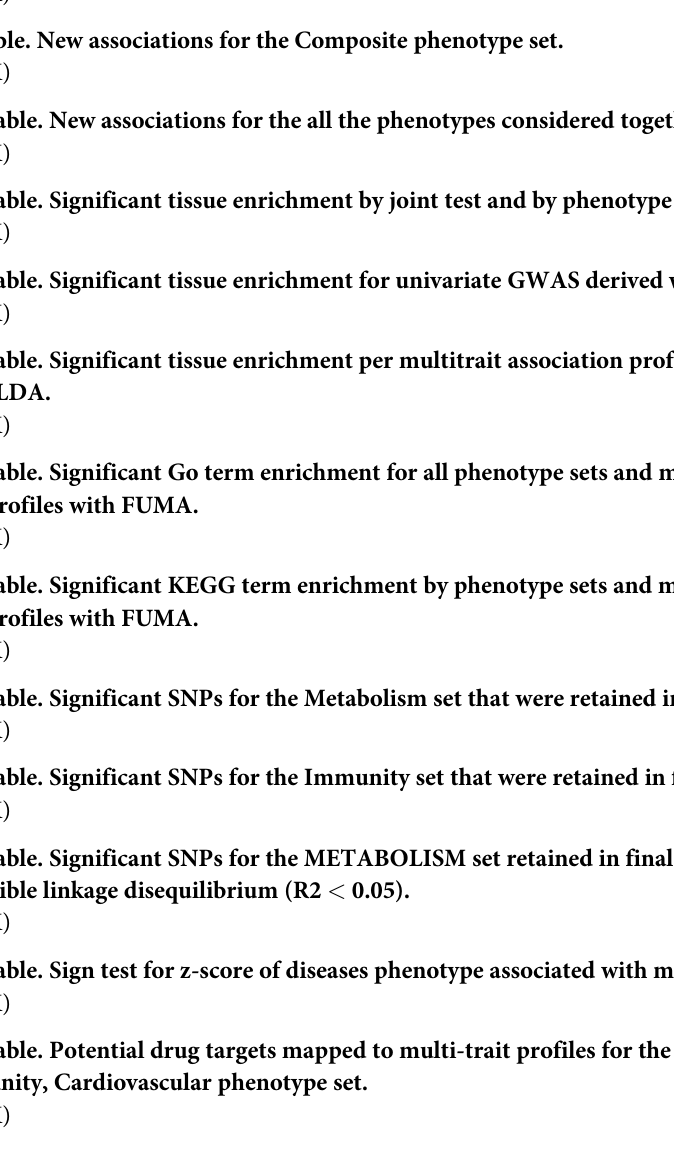
S3 Table. Genetic correlation. S4 Table. New associations for the Metabolism phenotype set. S5 Table. New associations for the Cardiovascular phenotype set. S6 Table. New associations for the Immunity phenotype set. S7 Table. New associations for the Anthropometry phenotype set. S8 Table. New associations for the Psychiatric phenotype set. S9 Table. New associations for the Composite phenotype set. S10 Table. New associations for the all the phenotypes considered together. S11 Table. Significant tissue enrichment by joint test and by phenotype set. S12 Table. Significant tissue enrichment for univariate GWAS derived with FUN-LDA. (XLSX) S13 Table. Significant tissue enrichment per multitrait association profile derived with FUN-LDA. S14 Table. Significant Go term enrichment for all phenotype sets and multitrait associa- tion profiles with FUMA. S15 Table. Significant KEGG term enrichment by phenotype sets and multitrait associa- tion profiles with FUMA. S16 Table. Significant SNPs for the Metabolism set that were retained in final clusters. S17 Table. Significant SNPs for the Immunity set that were retained in final clusters. S18 Table. Significant SNPs for the METABOLISM set retained in final clusters and with negligible linkage disequilibrium (R2 < 0.05). S19 Table. Sign test for z-score of diseases phenotype associated with metabolic traits. S20 Table. Potential drug targets mapped to multi-trait profiles for the Metabolism, Immunity, Cardiovascular phenotype